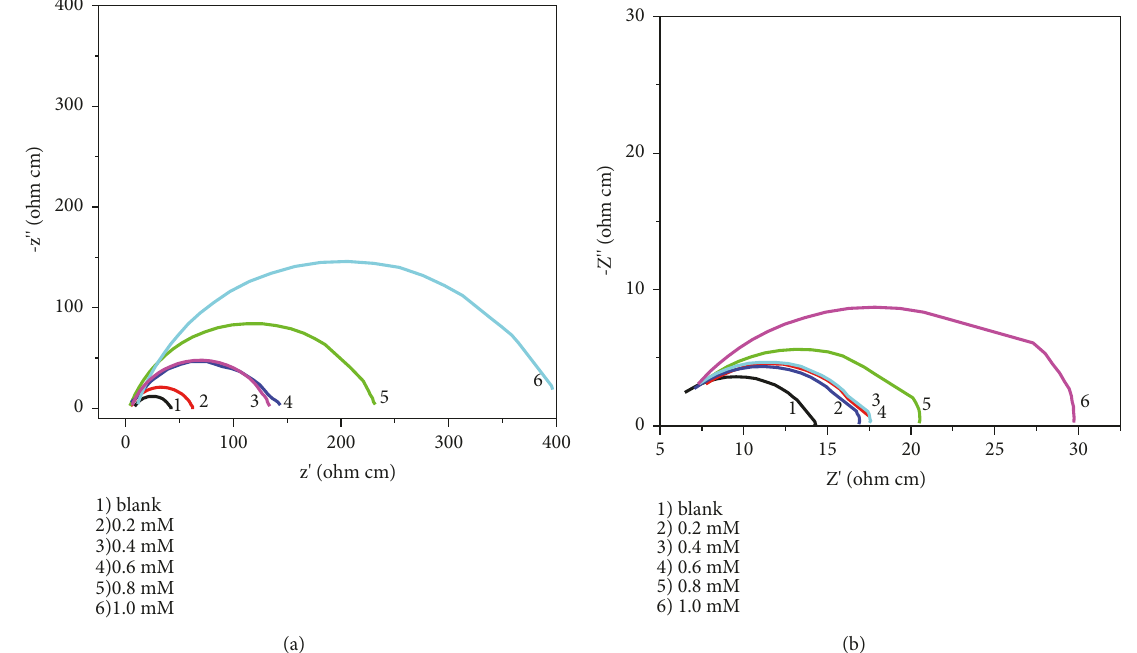
Figure 8: Nyquist plots of MS coupons with and without DmChDp in (a) 1M HCl and (b) 0.5M H 2 SO 4 .